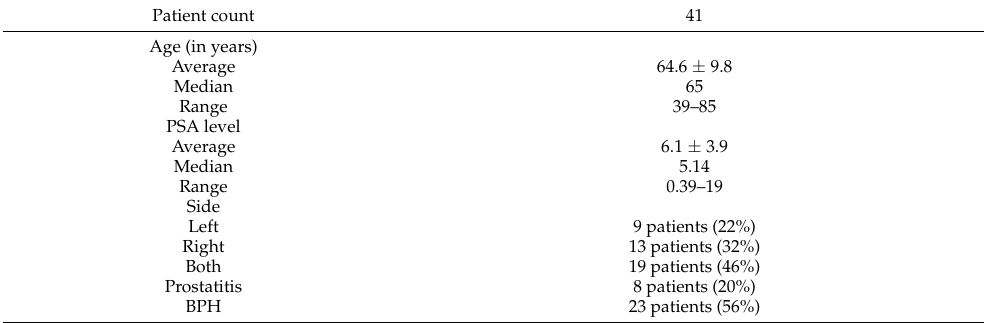
Table A1. Basic dataset characteristics.